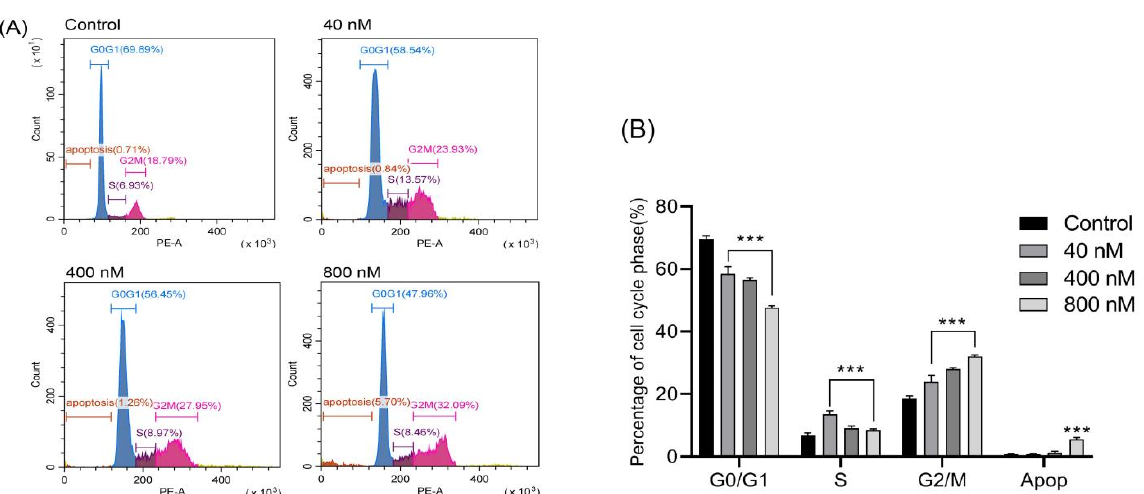
Figure 4. Effects of compound 3 on cell cycle distribution of Huh-7 cells determined by flow cytometry. ( A ) Histograms of cell cycle distribution after treatment with 0, 40, 400 and 800 nM compound 3 for 24 h. ( B ) Percentage of Huh-7 cell in G0/G1, S and G2/M phases after treatment with compound 3 . All data are the mean ± SD from three independent experiments. *** p < 0.001 vs. control group.